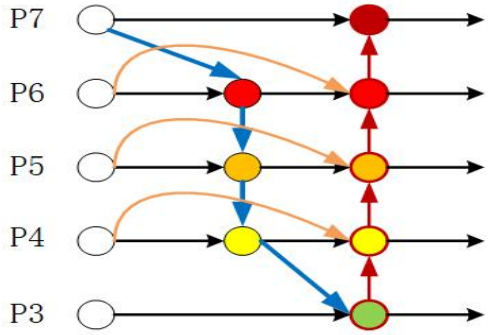
Figure 2. BiFPN structural diagram .